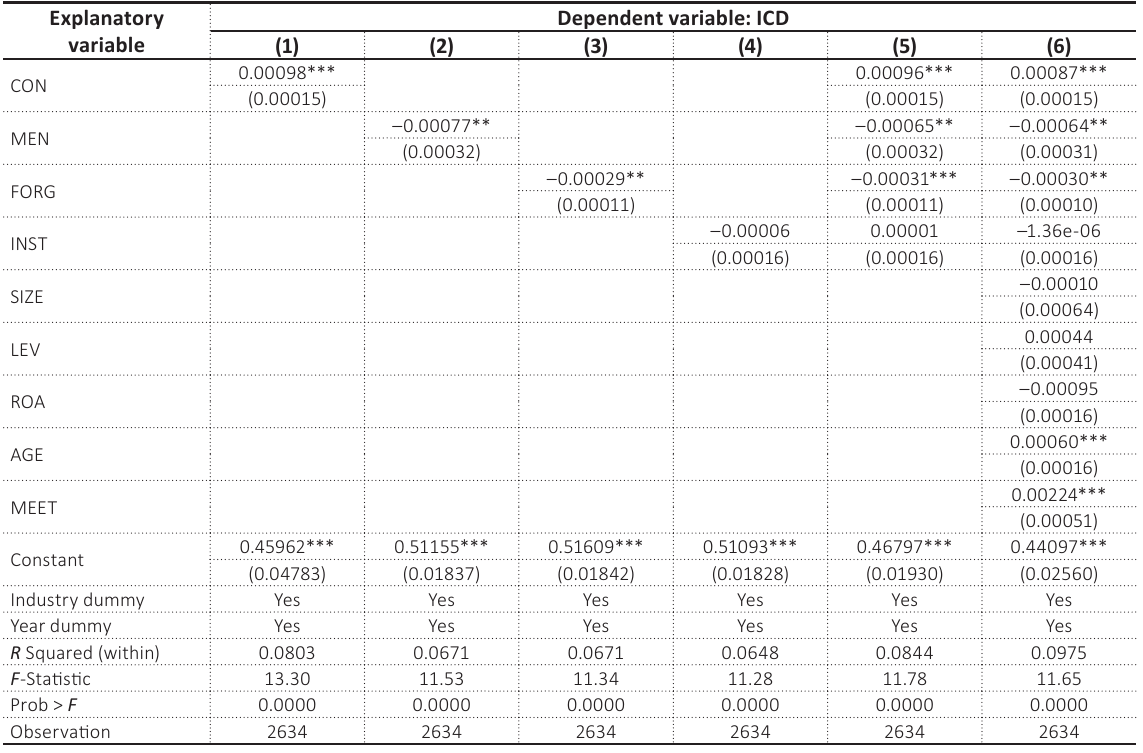
Table 5. Impact of ownership structure on intellectual capital